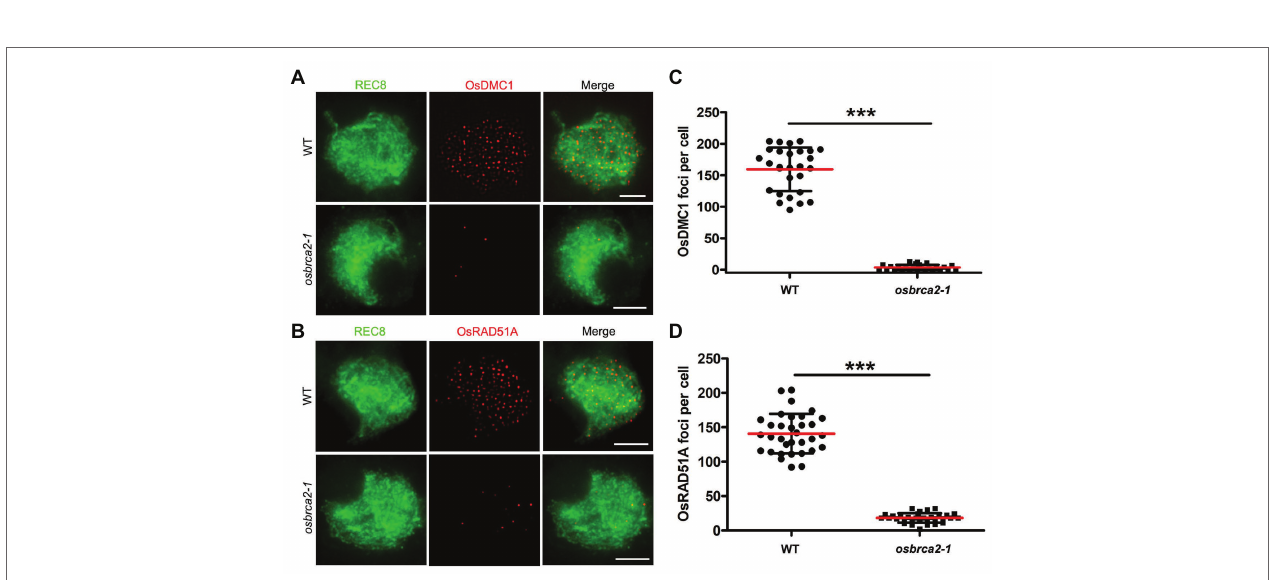
FIGURE 6 | Synapsis complex is not correctly installed in osbrca2-1 mutant. Dual immunolocalization of PAIR2 (red) (A) , ZEP1 (red) (B) and OsREC8 (green) in wild-type and osbrca2-1 PMCs. Bars = 5 μ